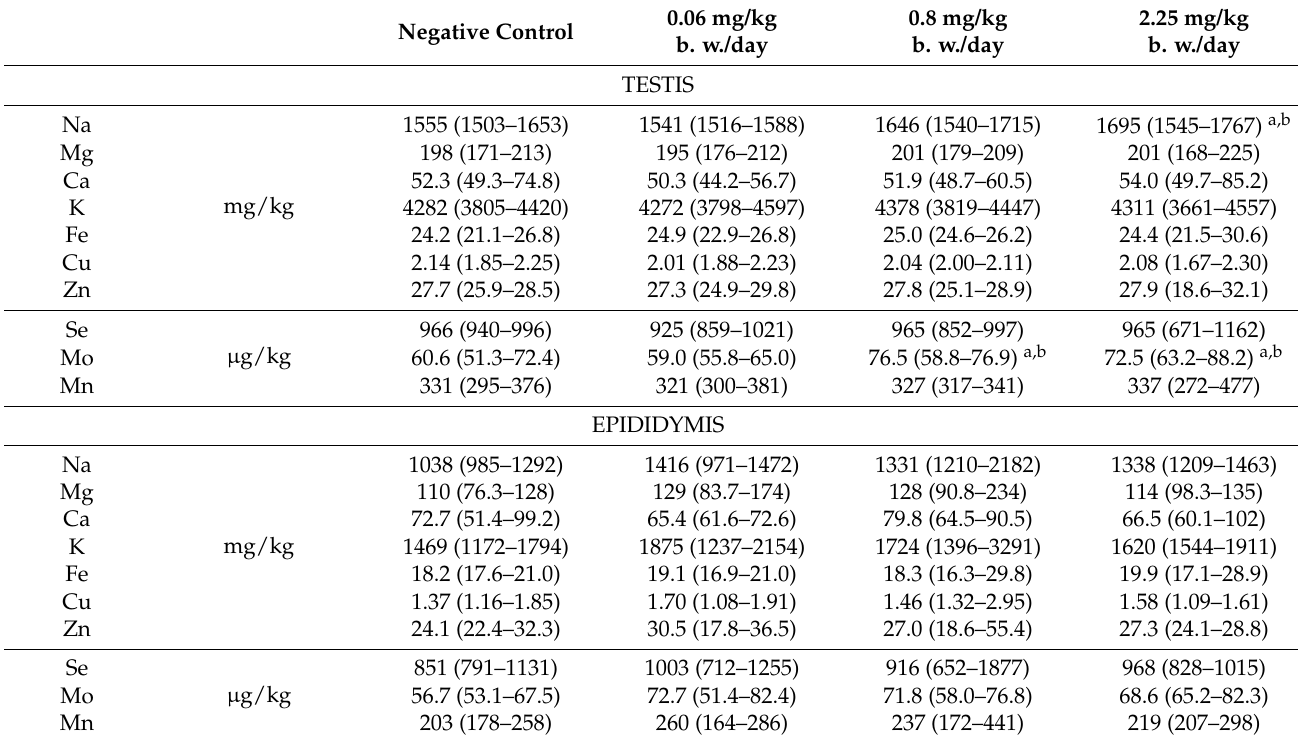
Table 1. Concentration of essential elements in the testis and epididymis of Wistar rats (N = 5 rats per group) treated orally for 28 consecutive days with imidacloprid at doses of 0.06 mg/kg b. w./day, 0.8 mg/kg b. w./day, and 2.25 mg/kg b. w./day and the respective negative control 1